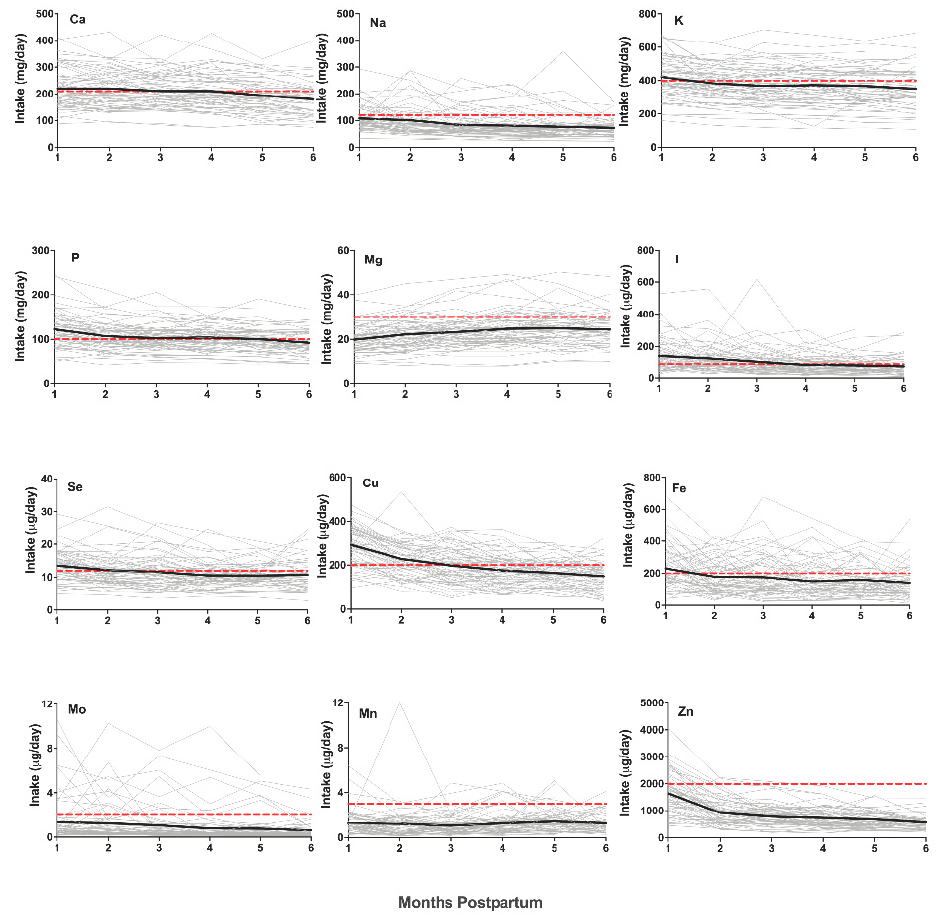
Figure 2. Intake of macro- and trace elements in human milk over the first 6 months postpartum. The intake of iodine decreased over the first 6 months pp and was higher in the first month compared to months 3–6 ( p < 0.01 for all comparisons). Compared to the recommended AI, the mean intake was sufficient in the first 3 months but fell below the AI for months 4–6 (Figure 2). The grey lines indicate individual plots, the black lines indicate mean values, and the dashed red line shows the AI recommendation. Abbreviations: Se, selenium; Cu, copper; Mn, manganese; Mo, molybdenum; Fe, iron; Zn, zinc; Ca, calcium; Na, sodium; K, potassium; P, phosphorus; Mg, magnesium; I, iodine. Fewer than 50% of the infants met the AI recommendation for selenium by 2 months. Fewer than 50% of the infants met the AI recommendation for copper or iodine by 3 months. For manganese and molybdenum, the largest proportion of infants met the AI recommendation at 4 months, 10.5%, and 2 months, 16.9%, respectively. Fewer than 50% of the infants met the AI recommendation for iron or calcium at any point. By 3 months, no infants met the AI recommendation for zinc. Fewer than 23% of the infants met the recommended sodium intake at any time point. Fewer than 50% of the infants met the recommended potassium or phosphorus intake by 2 months and thereafter. For magnesium, the largest proportion of infants met the AI recommendation at 5 months, 25%. The intake of selenium was the highest in the first month ( p < 0.01 for all compar- isons) and decreased throughout the first six months pp. The mean intake relative